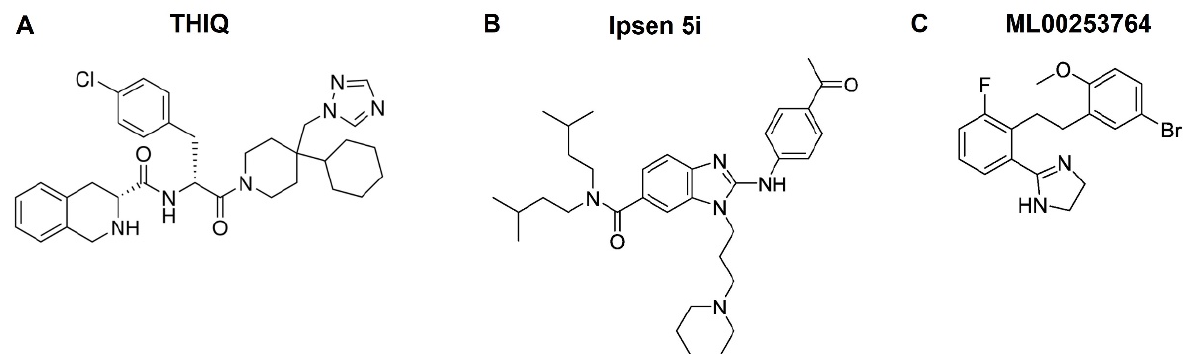
Figure 2. Chemical structures of THIQ ( A ), Ipsen 5i ( B ), and ML00253764 ( C ).